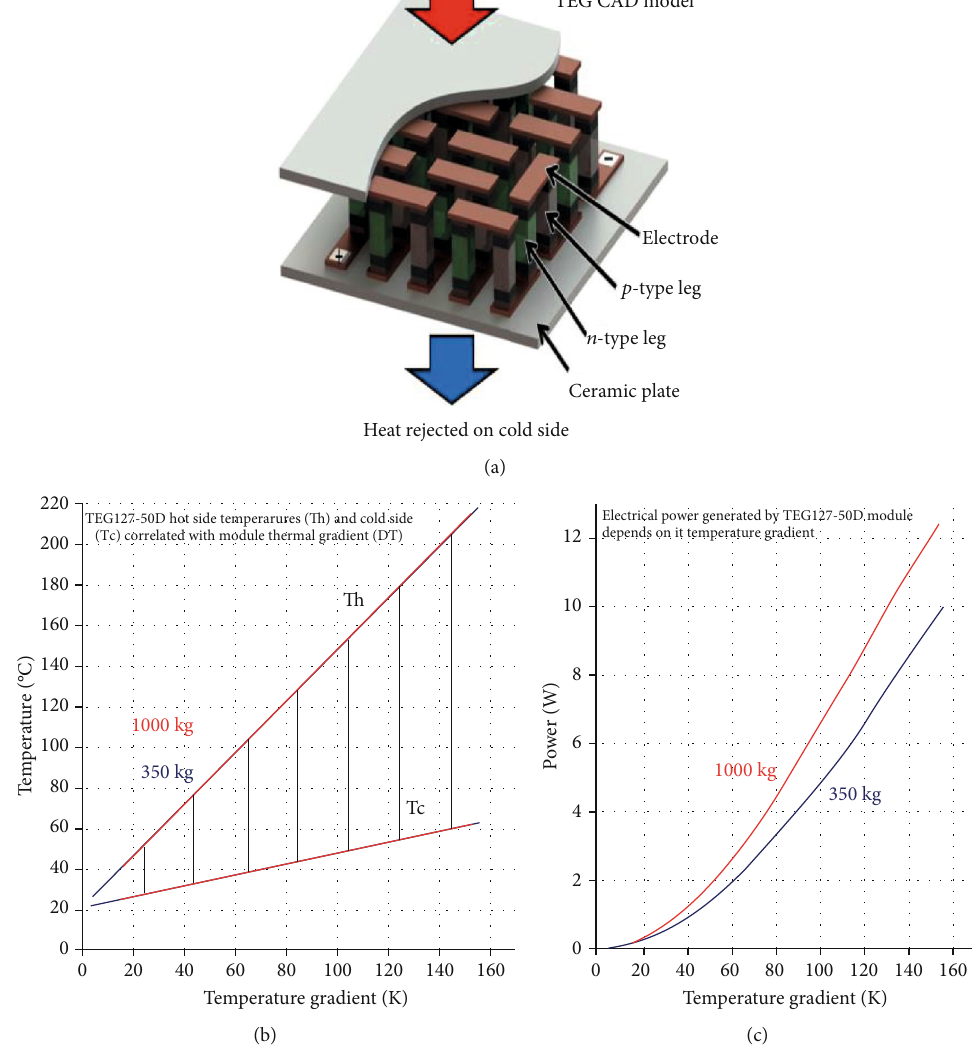
Figure 6: High-temperature TEG characterisation (adapted from